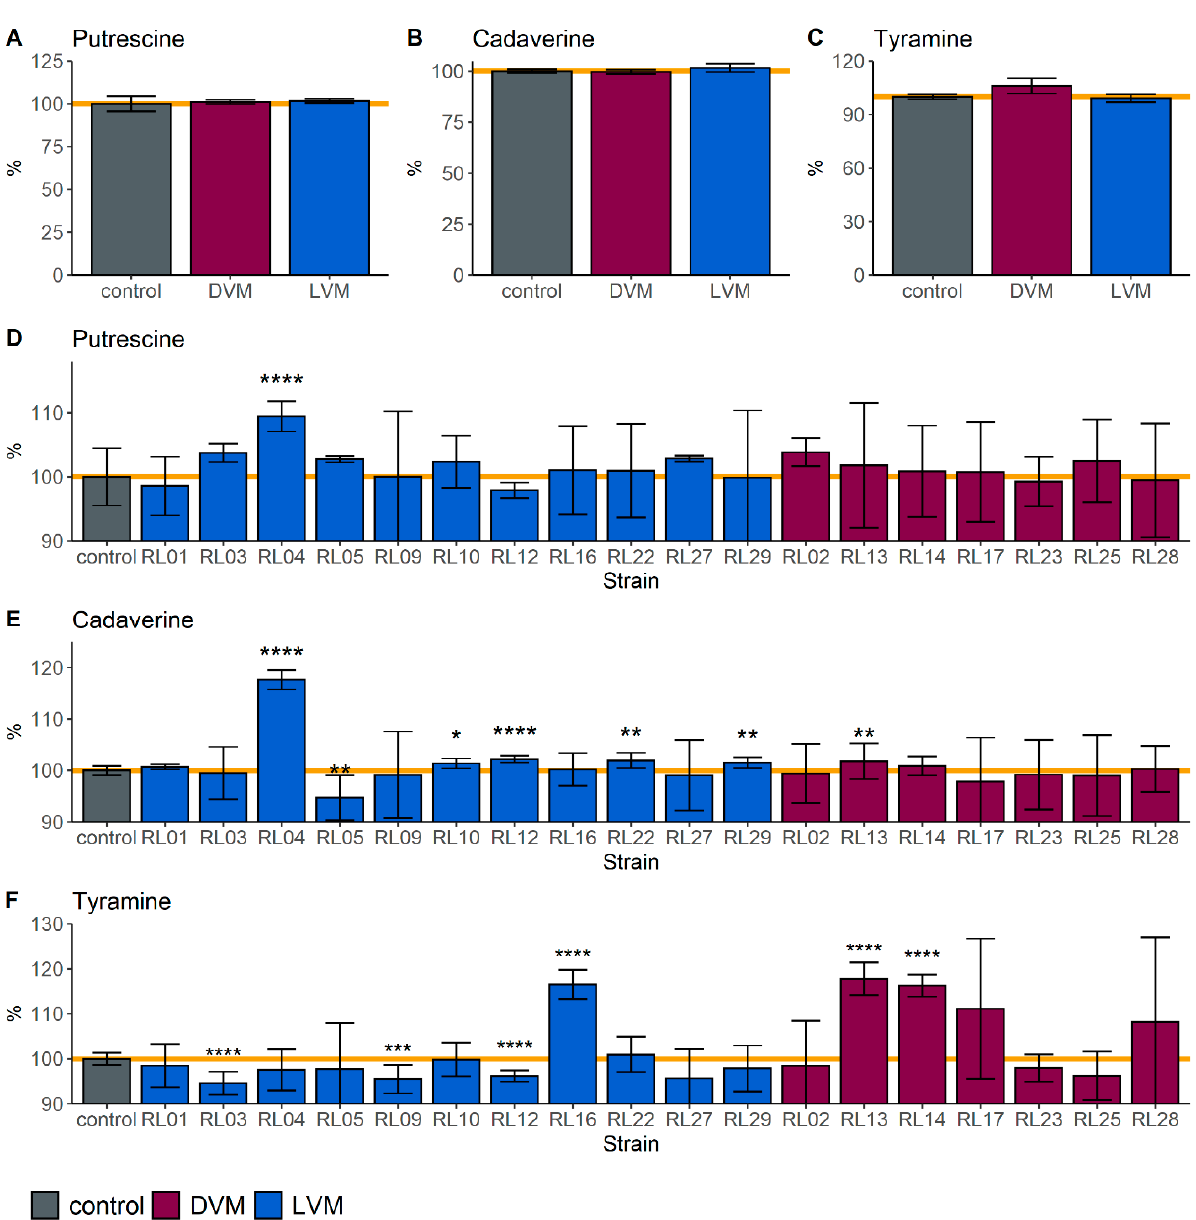
Figure 2. Production and degradation of biogenic amines. Semi-quantitative metabolomics analysis of the differences in putrescine ( A , D ), cadaverine ( B , E ), and tyramine ( C , F ), between the control (VDMP media only) and spent media by microbiota status ( A – C ) and by strain ( D – F ). Burgundy represents strains isolated from dysbiotic vaginal microbiota (DVM) and blue represents strains isolated from Lactobacillus dominated vaginal microbiota (LVM). Data are represented as the means of 3 independent experiments (* p < 0.05, ** p < 0.01, *** p < 0.001, **** p < 0.0001).